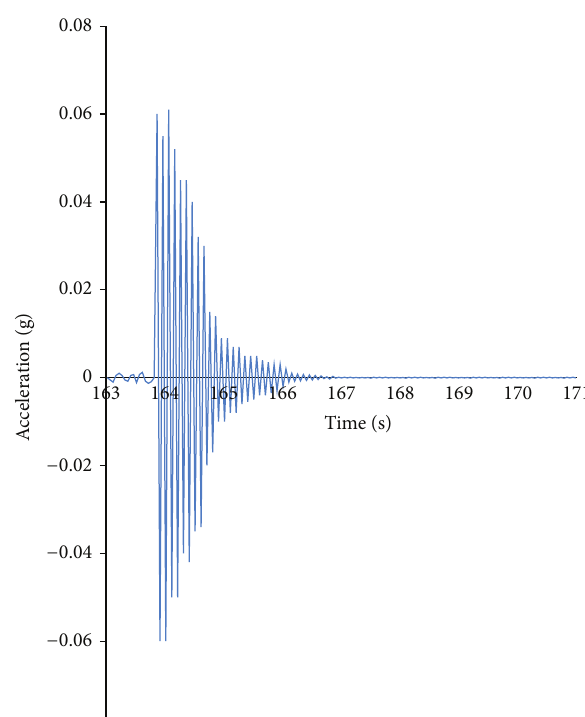
Figure 3: Acceleration response of sensor.